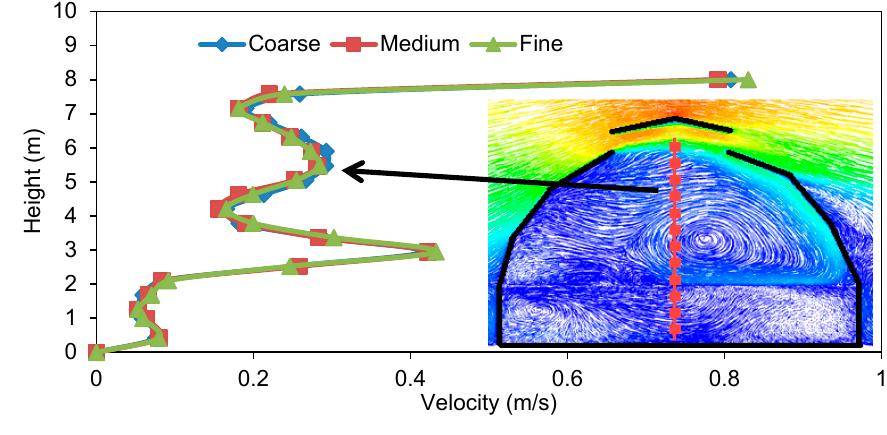
Figure 5. Sensitivity analysis of the computational modelling.